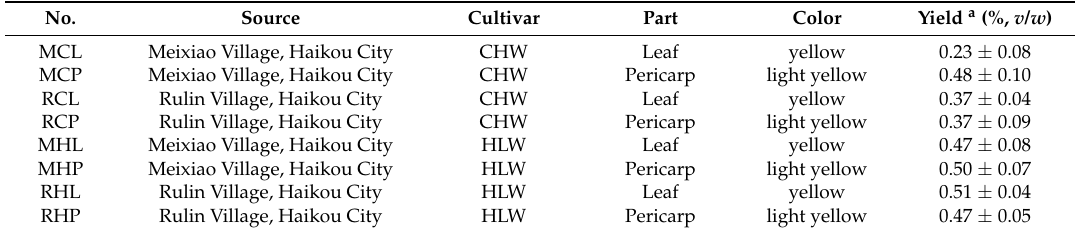
Table 1. Sources of Clausena lansium samples and extraction results of